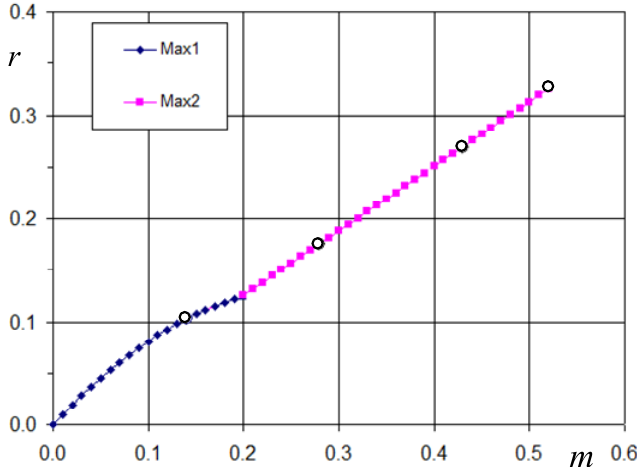
Figure 8. Maximum of the normalized peak-to-peak current ripple amplitude as function of modulation